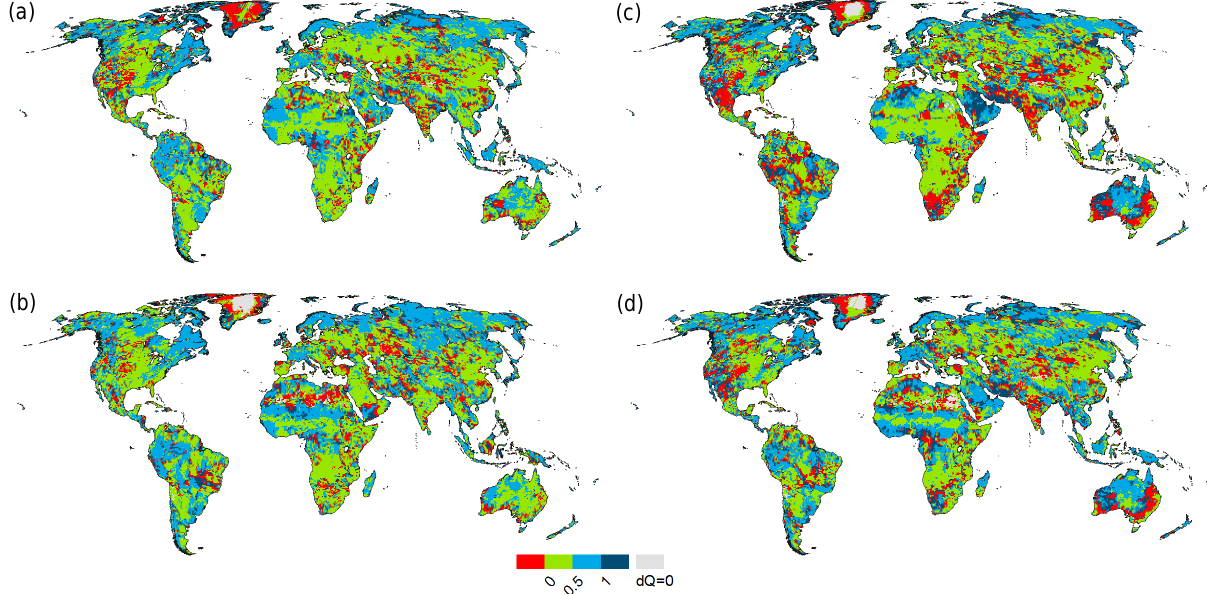
Figure B2. Indicator A n representing dominance of the change of P for the change in Q (Eq. 3) from 1941–1970 to 1971–2000. Grey color indicates that the change in Q is zero, such that A n cannot be computed. Red color indicate areas where A n is negative, i.e., change in P had the opposite sign of the change in Q ; therefore, P was not the dominant driver for change in Q . Results are shown for WaterGAP as driven by the climate forcings GSWP3 (a) , PGFv2.1 (b) , WFDEI_hom (c) , and WFD (d)